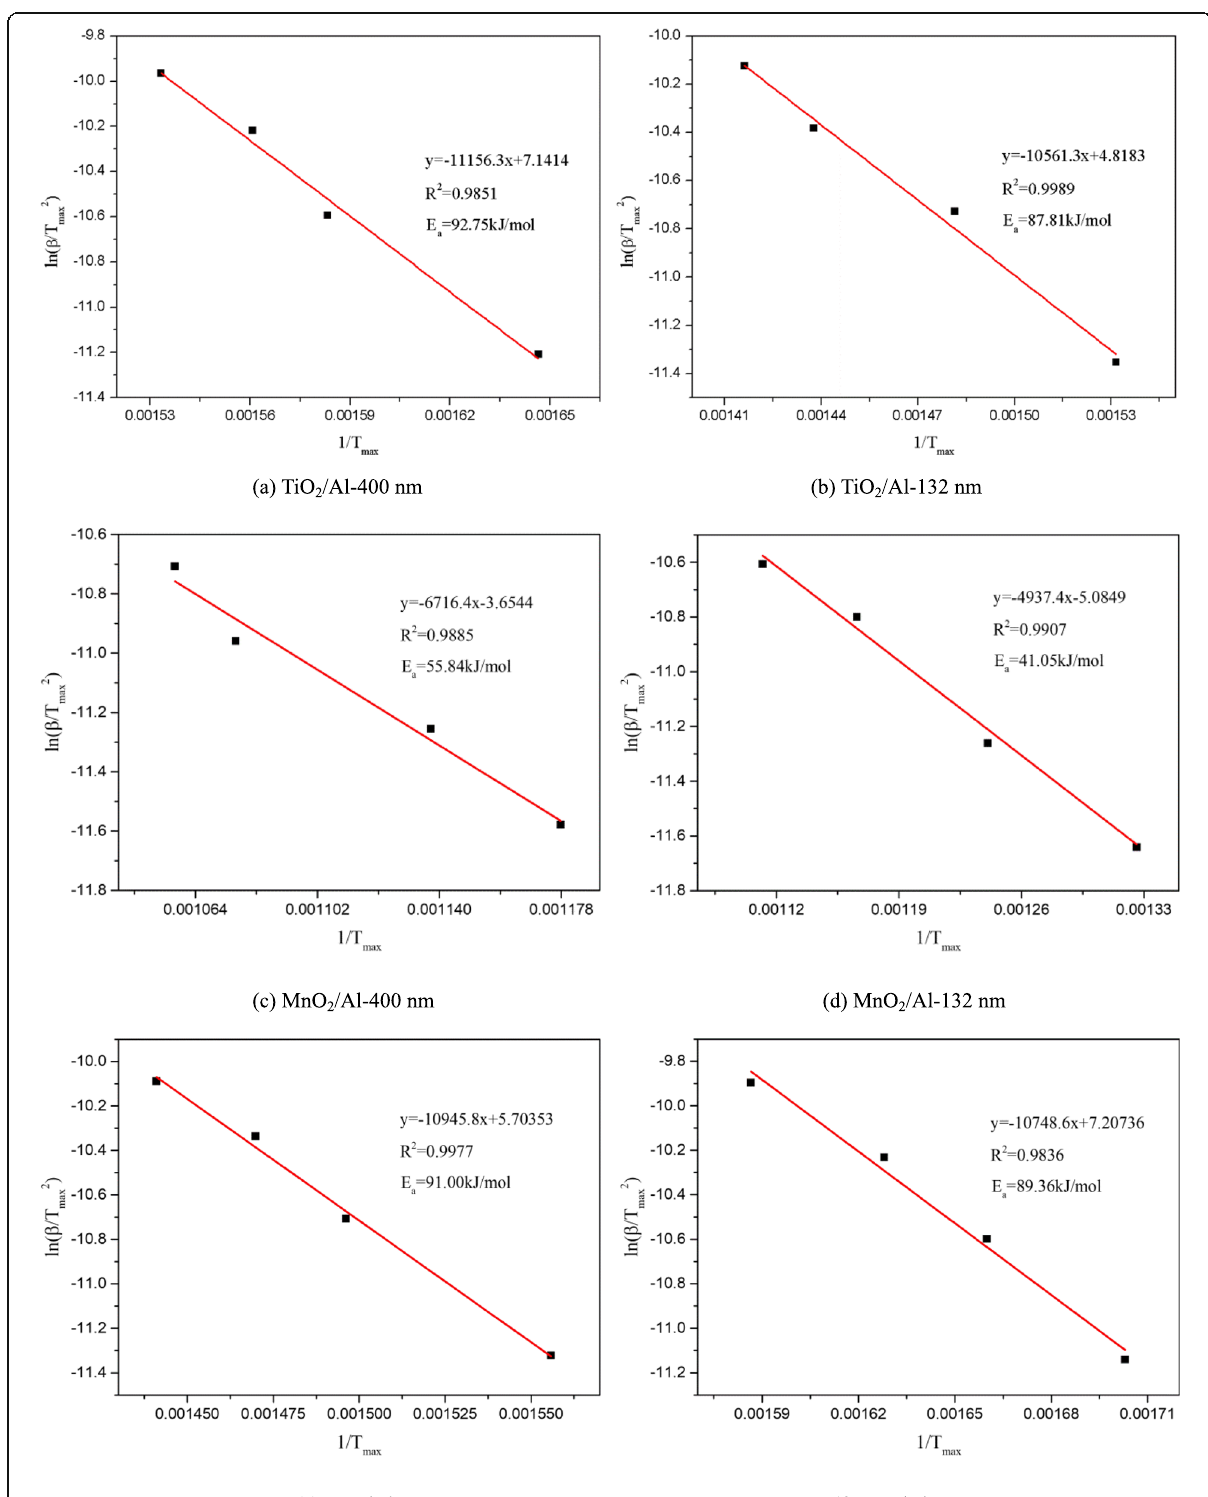
Fig. 9 The activation energy was calculated using the Kissinger method. a TiO 2 /Al-400nm, b TiO 2 /Al-132 nm, c MnO 2 /Al-400 nm, d MnO 2 /Al-132 nm, e CuO/Al-400 nm, and f CuO/Al-132 nm (here, the β is the heating rate of DTA analysis, and T max is the peak temperature of the exothermic